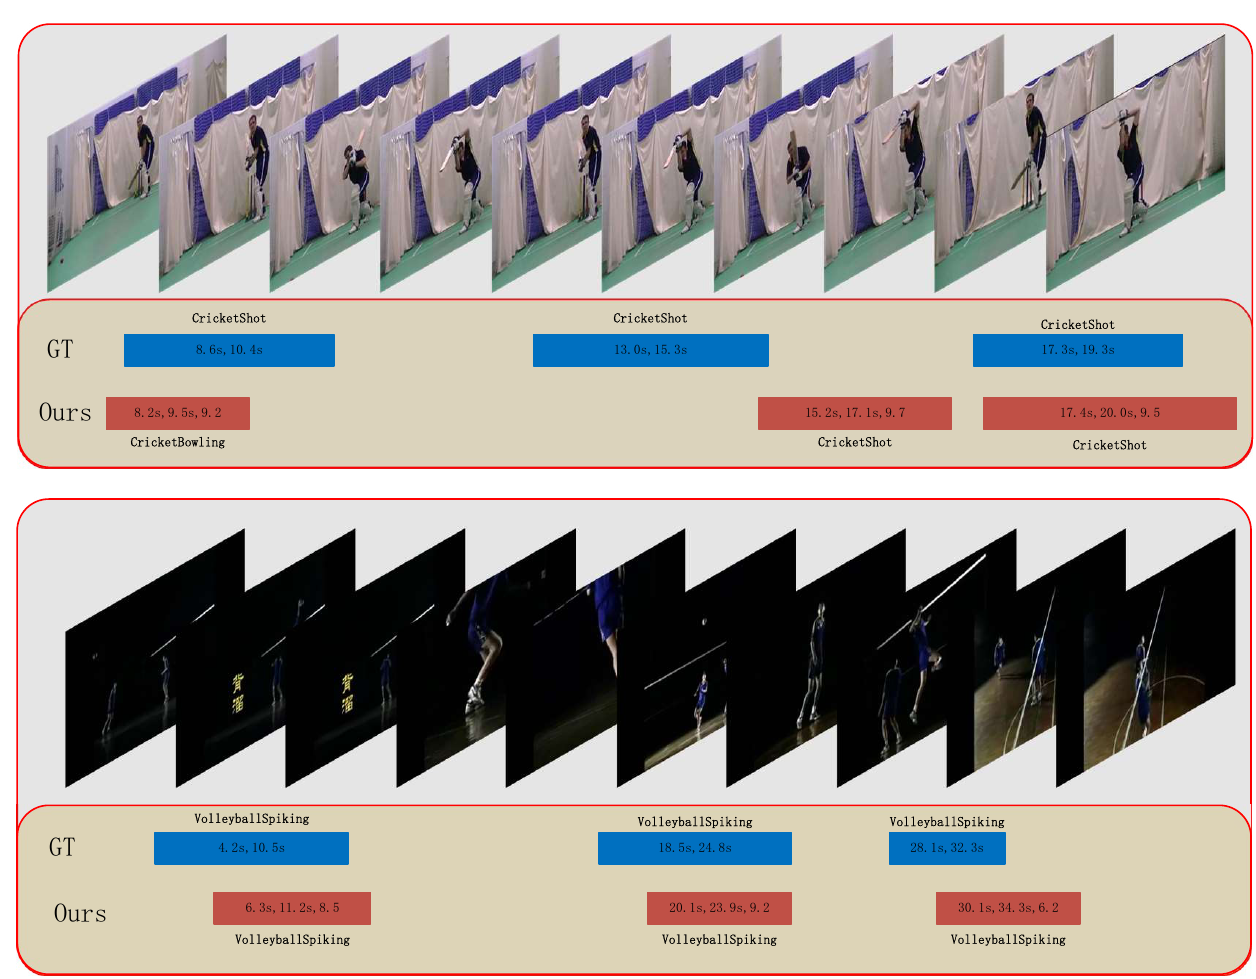
Figure 7. Qualitative examples of the predictions of our network on the THOMOS’14 data set. The blue mark is the ground truth, and the number indicates the start and end time of the action. The red mark is the prediction result, which shows not only the start and end times of the forecast but also the confidence (each scaled by a factor of 10 × ) of the